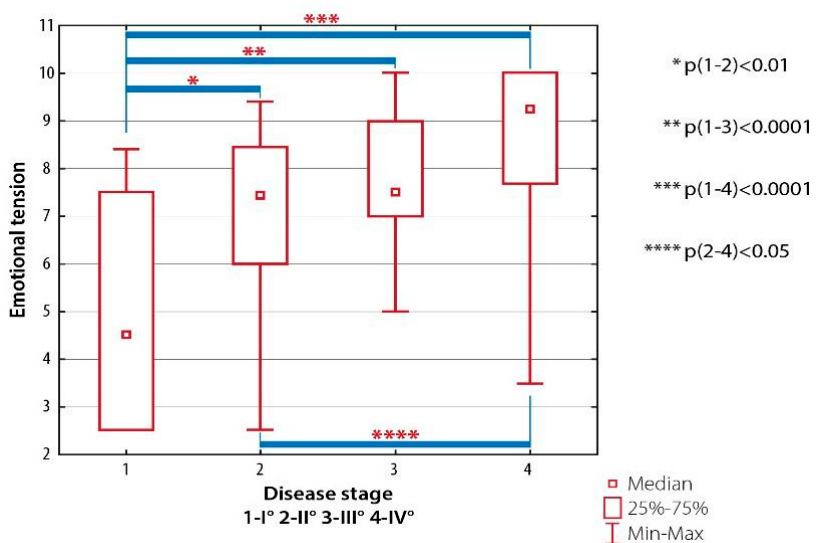
Figure 7. Inter-group differences in emotional well-being scored with AIMS-2: emotional tension, depending on the radiological classification of RA (the Steinbrocker classification). Deterioration of mood correlated with duration of RA (Figure